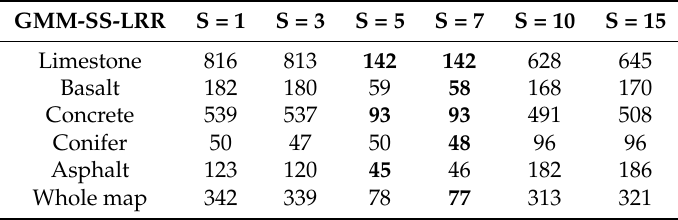
Figure 14. ( a ) The synthetic dataset abundance maps for the Ground truth and GMM; and ( b ) the corresponding abundance maps with the different size of the superpixels. From top to bottom: S = 1, 3, 5, 7, 10, 15. From left to right: Superpixel map, limestone, basalt, concrete, conifer and asphalt. Table 7. GMM-SS-LRR abundance errors with different sizes of superpixels for synthetic